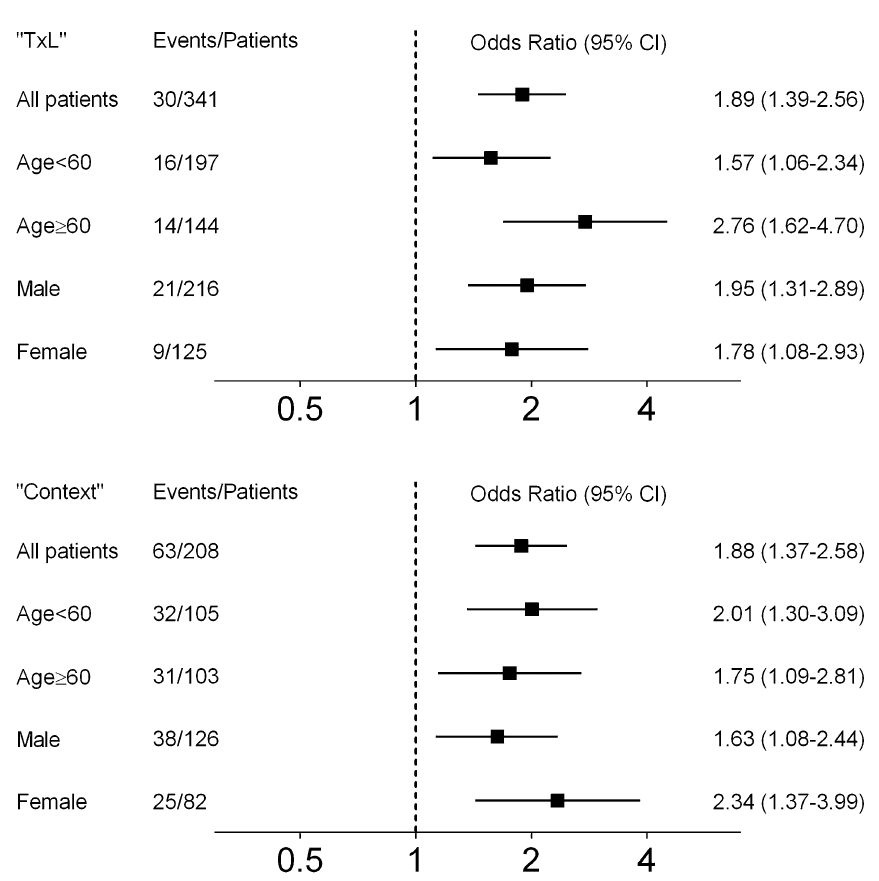
Figure 2. The graphs show the odds ratios and 95% confidence intervals (95% CI) for delayed raft function in the validation cohorts “TxL” and “CONTEXT”, using logistic regression to characterize the association between continuous pretransplant plasma endotrophin per increase in standard deviation and delayed graft function according to subgroup in the unadjusted analysis (Model 1). Subgroups included: Age < 60 years; Age ≥ 60 years; Male recipient; Female